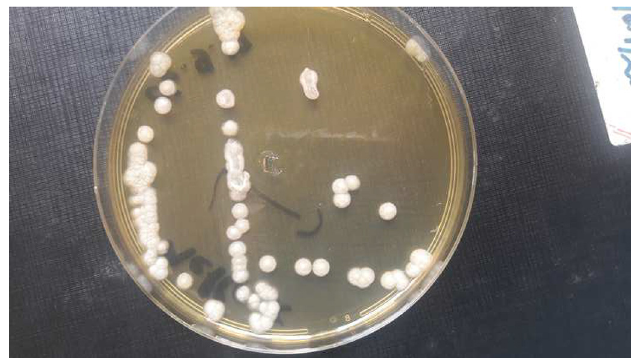
Fig. 2. Macroscopic image of Saprochaete capitata . 48-hour colonies grown on Sabouraud-Chloramphenicol agar medium.